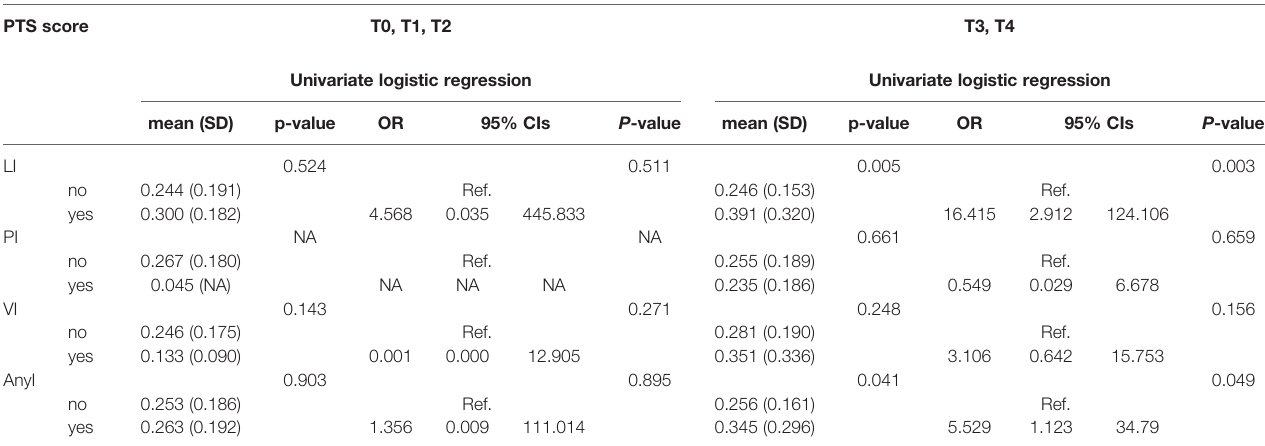
TABLE 4 | Predictive values of the PTS score for metastasis strati fi ed by T stage in colon cancer. PTS score T0, T1,